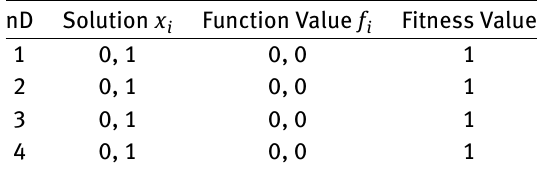
Table 5: Digit Cycle Results for Effati and Nazemi example